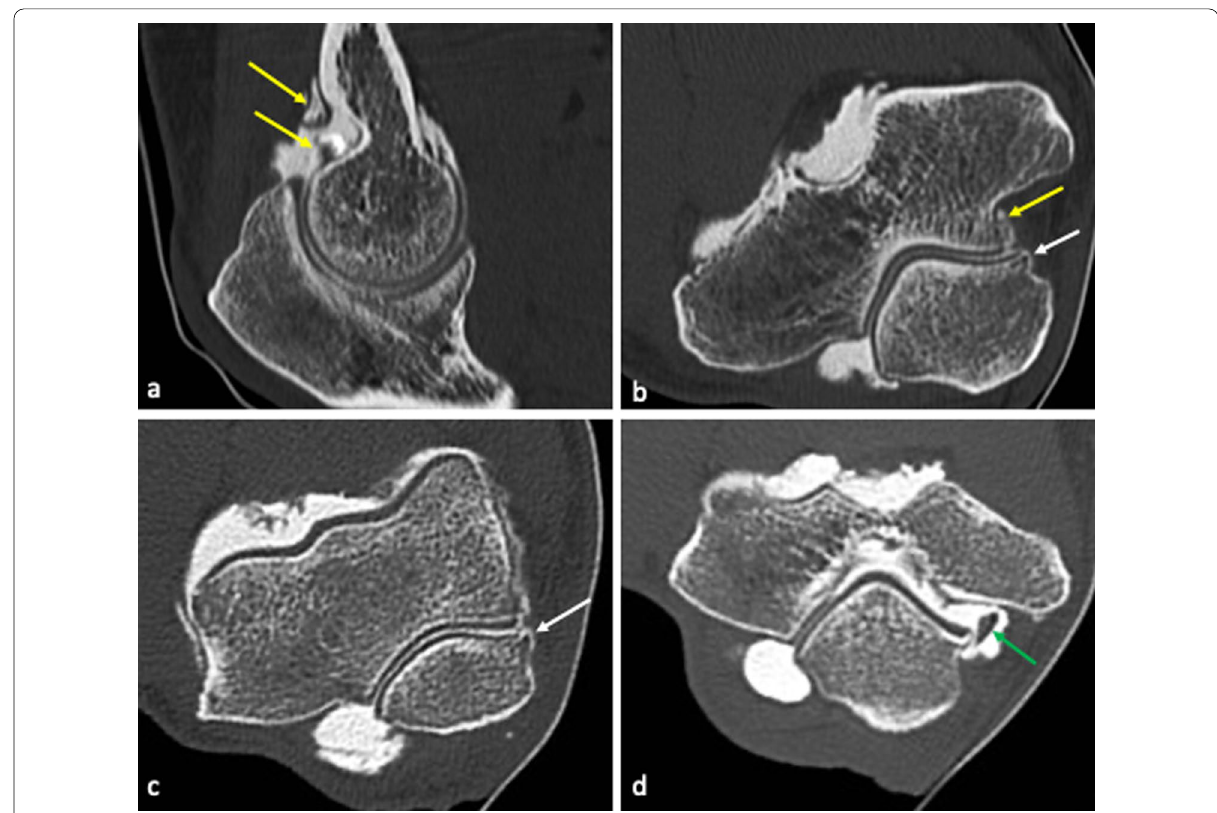
Fig. 8 CT-arthrography sagittal ( a ) and axial ( b – d ) images of two different patients with valgus extension overload (VEO) syndrome, showing osteophyte formation ( b , c ) over the medial aspect of the olecranon (white arrows) and an intra-articular loose body ( d ) located medially at the posteromedial recess (green arrow). Synovial thickening associated to synovitis ( a , b ) is also noticeable (yellow